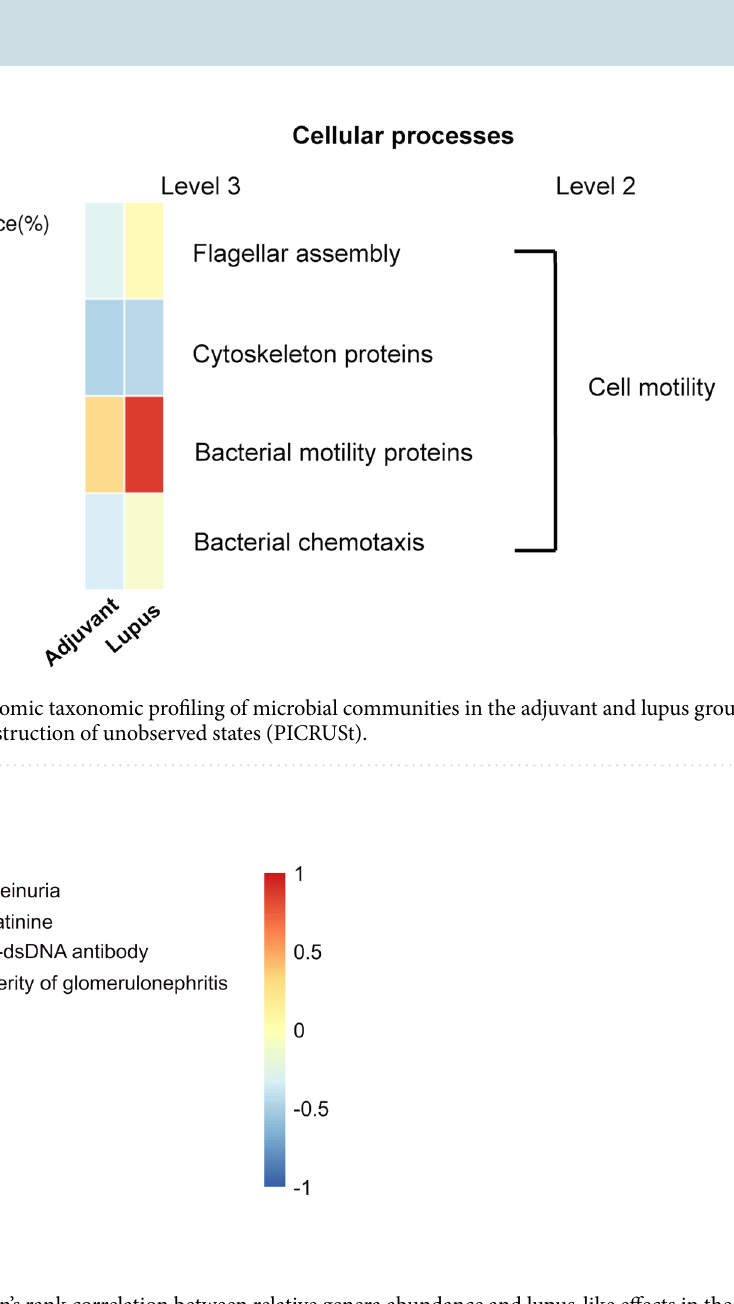
Figure 6. Spearman’s rank correlation between relative genera abundance and lupus-like effects in the lupus group. Heat map based on the correlation coefficient values. + P < 0.05 and + + P <